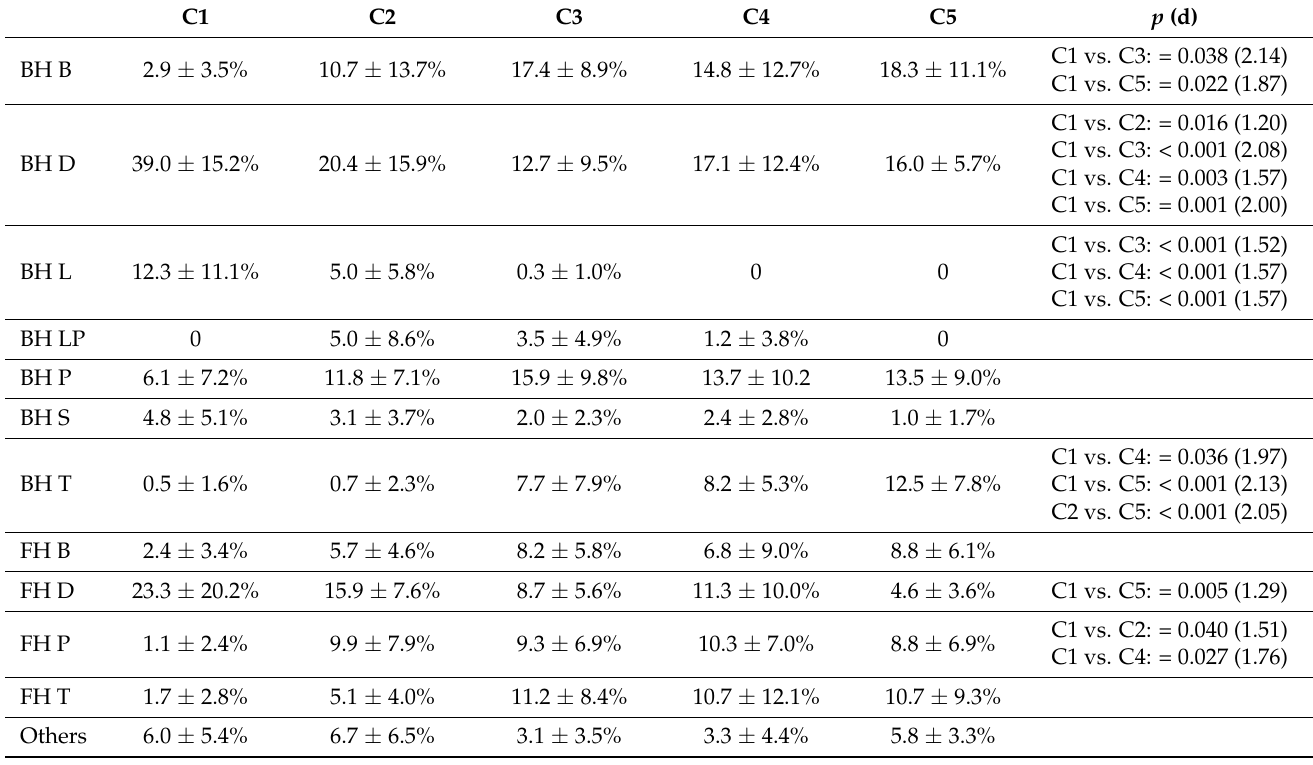
Table 9. Distribution of strokes type in error outcome for each class (mean ± SD).